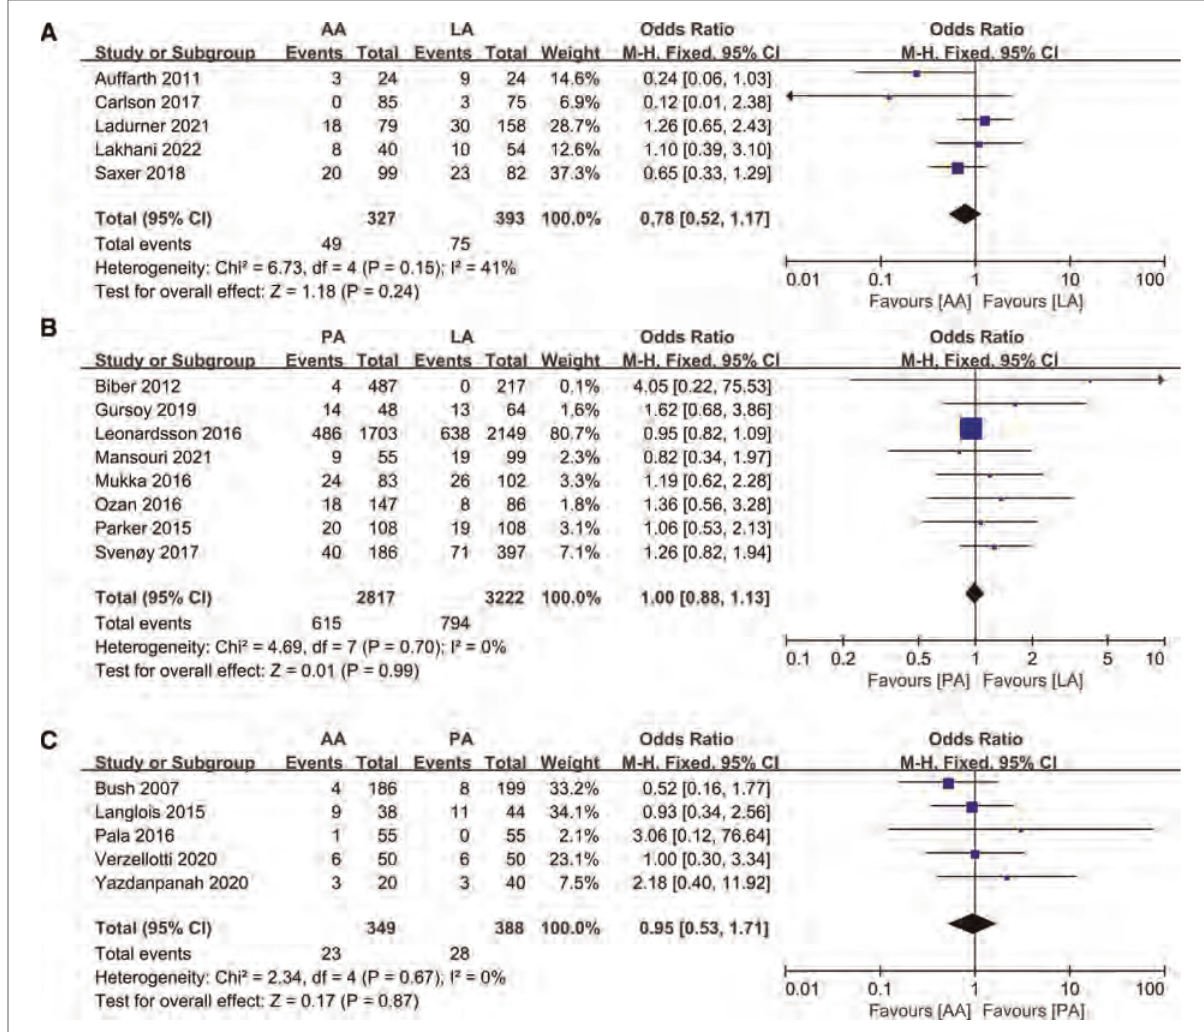
FIGURE 10 Forest plot comparison of mortality. ( A ) Anterior approach and lateral approach, ( B ) Posterior approach and lateral approach, ( C ) Posterior approach and anterior